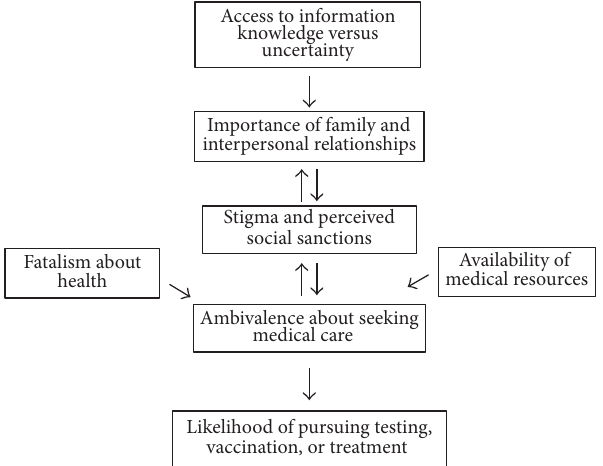
Figure 1: Multiple factors that have an impact on how HBV infection is perceived, which can affect psychological well-being and social interactions and serve as a barrier to seeking testing, vaccination, and